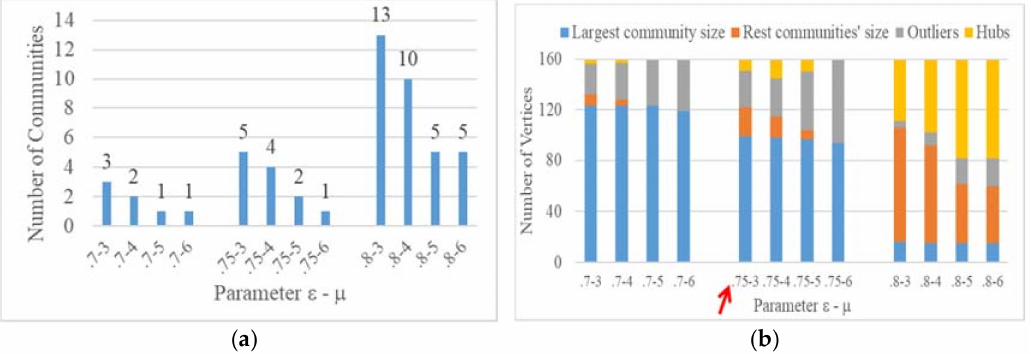
Figure 12. Different parameter settings for SCAN on the high-speed train network: ( a ) number of communities; and ( b ) ratio of